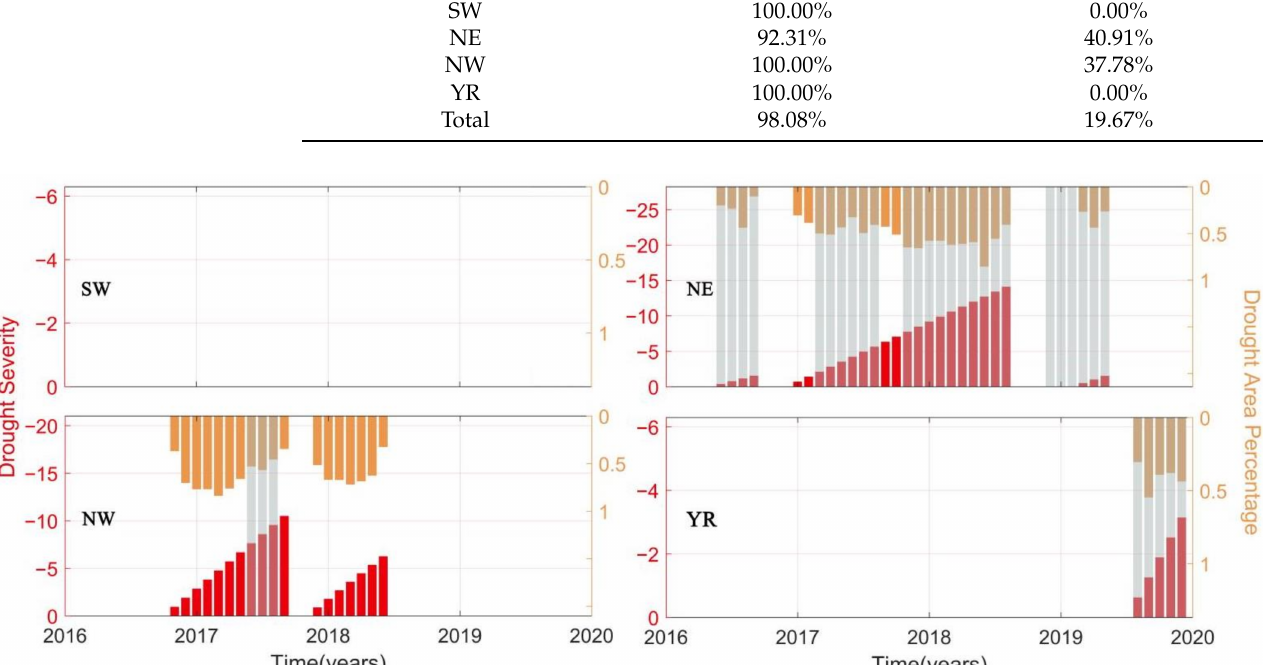
Figure 7. The comparison of the drought events determined by the calibrated drought characterization approach during